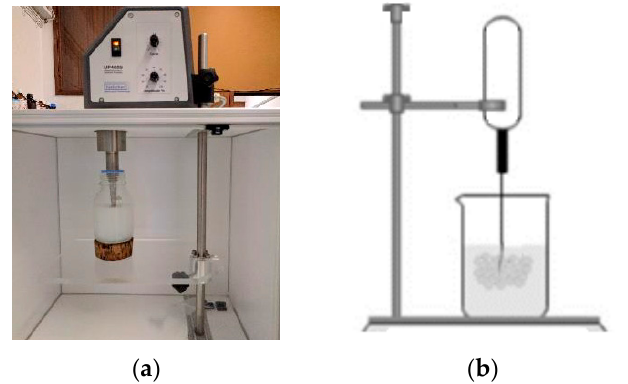
Figure 1. Grout preparation: ( a ) Sonicator for dispersion of NS; ( b ) Sonicator apparatus used. The entire NHL and HRWR powders were then added to the solution containing NS.